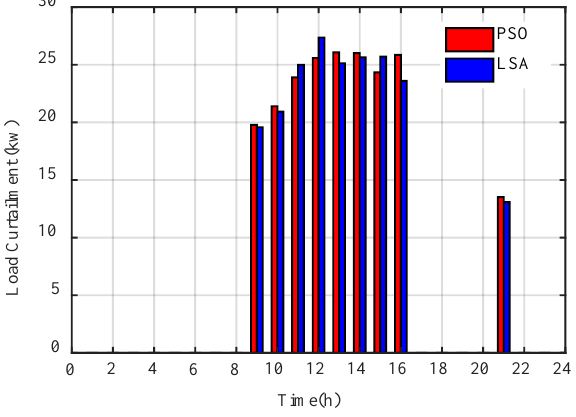
Figure 12. Load curtailment in each hour.